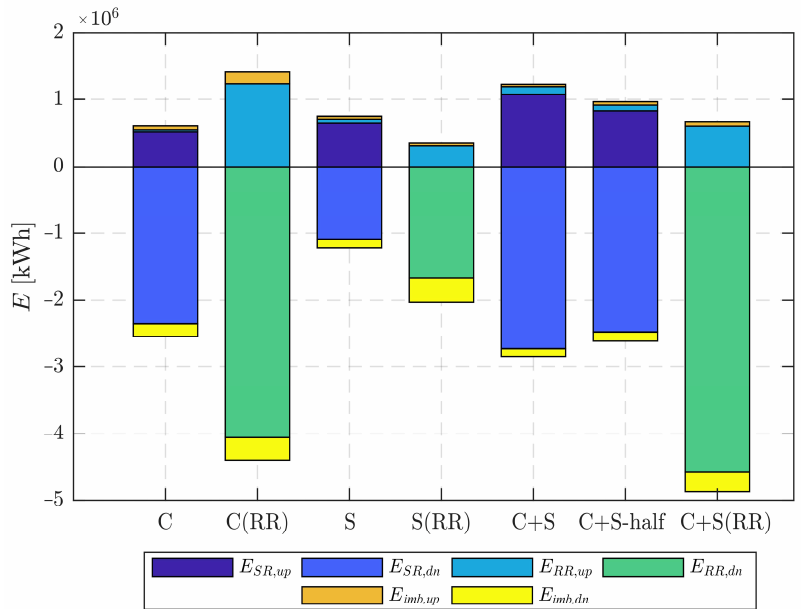
Figure 8. Enabled Virtual Unit’s market exchanges.